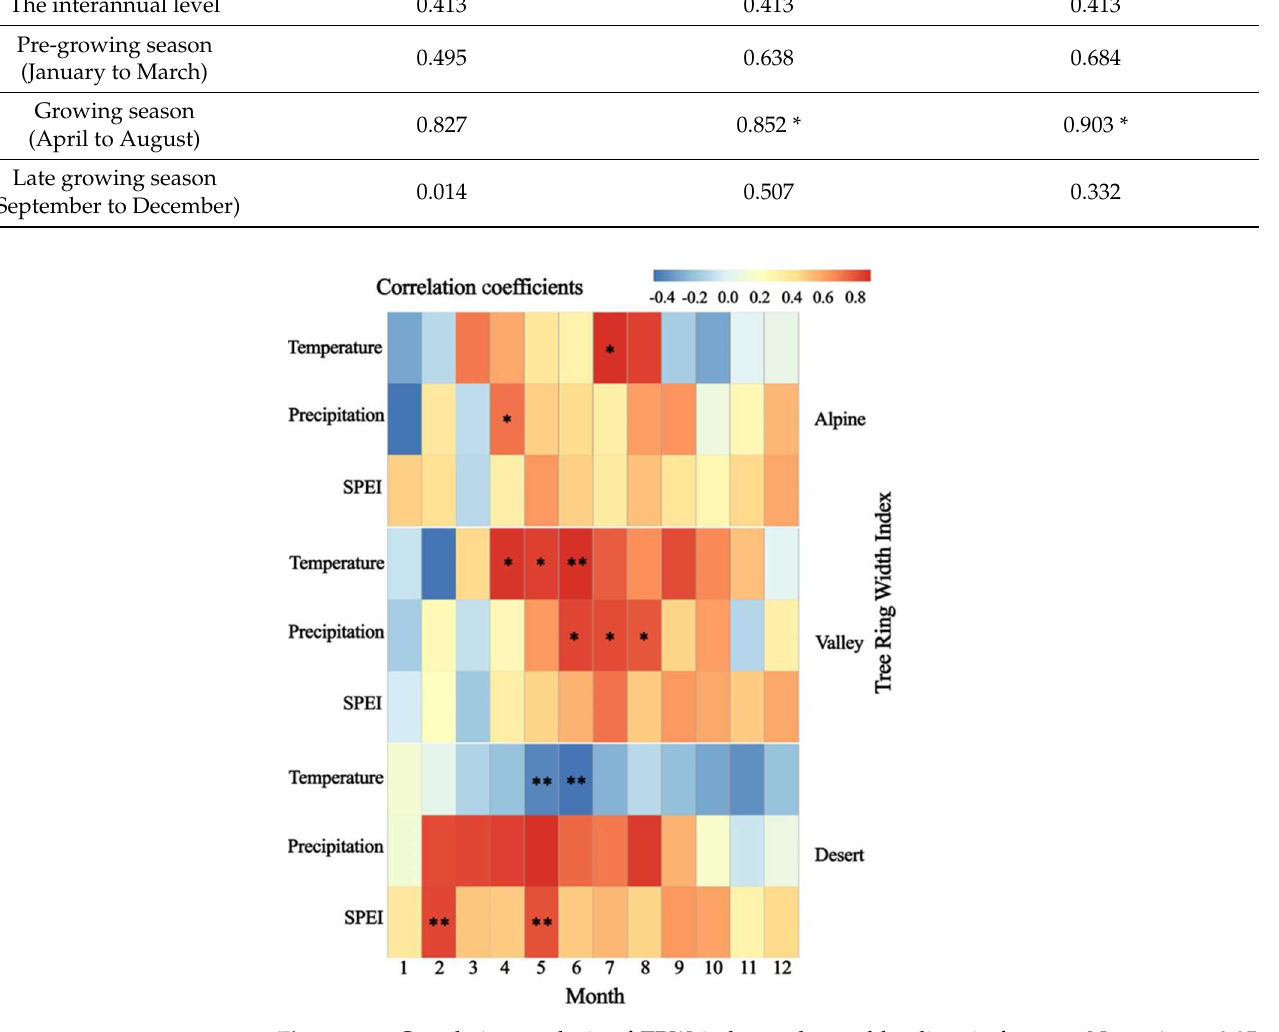
Figure 10. Correlation analysis of TRW index and monthly climatic factors. Note: * p < 0.05, ** p < 0.01.